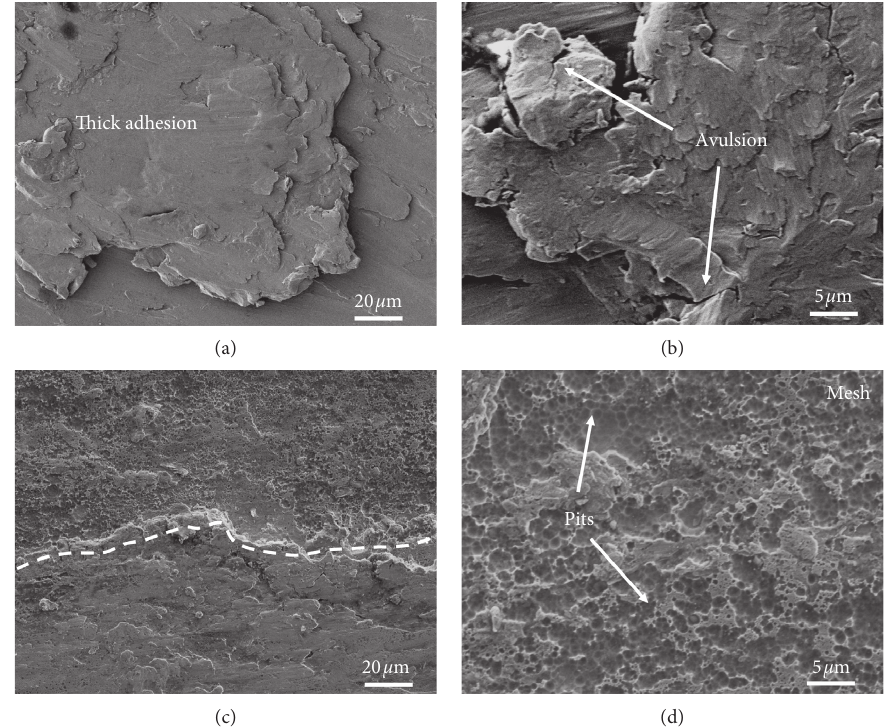
Figure 11: SEM images of the surfaces of Inconel 625 worn by GCr15: (a) 25 ° C, 525mm/s, 15N; (c) 500 ° C, 525mm/s, 15N; (b, d) enlarged views of (a) and (c), respectively.